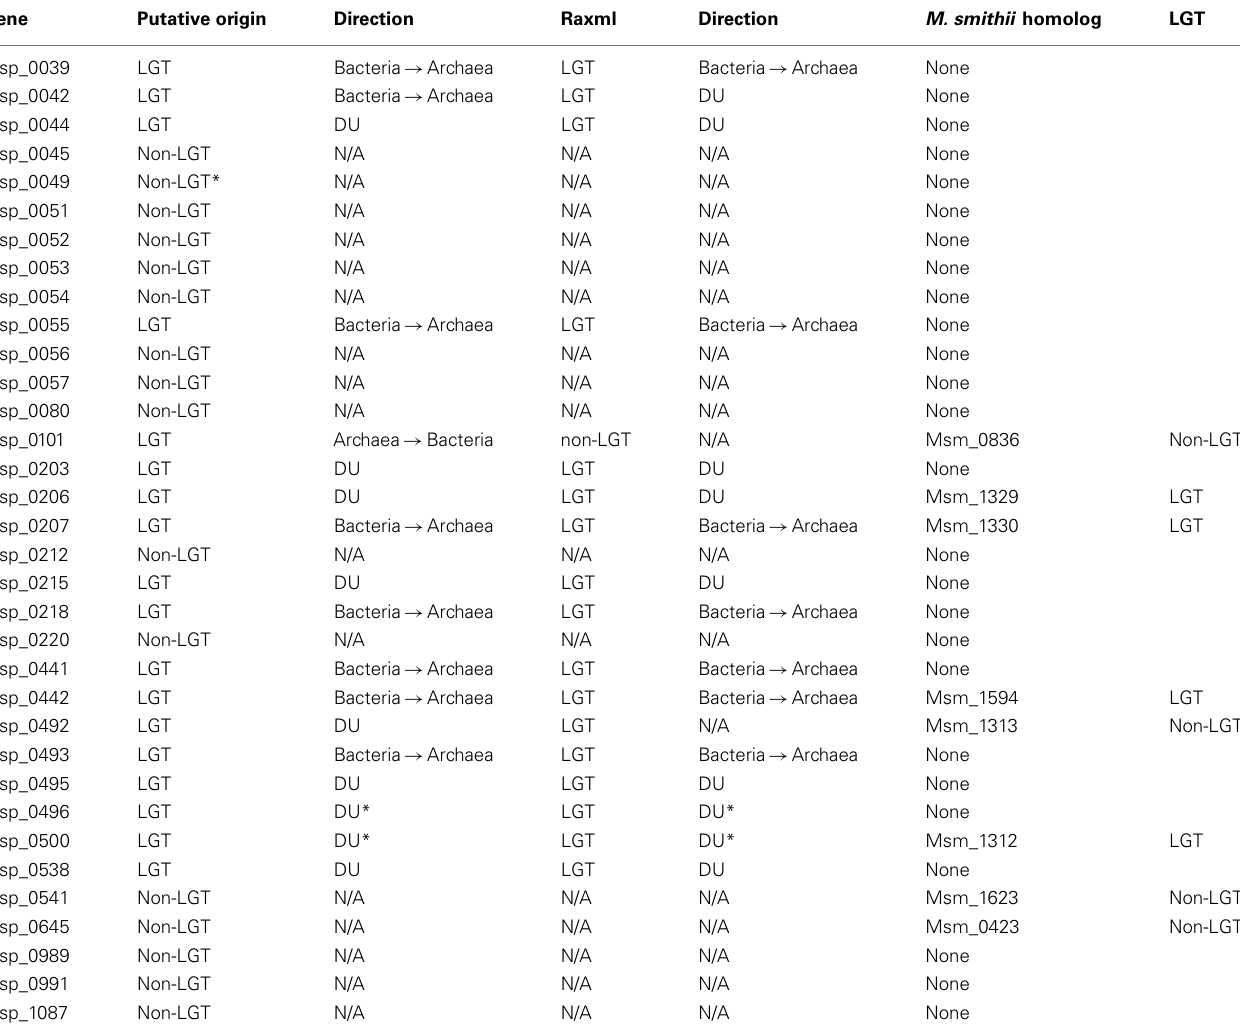
Table 1 | Putative glycosyltransferases present in M. stadtmanae , and their inferred origin. Gene Putative origin Direction